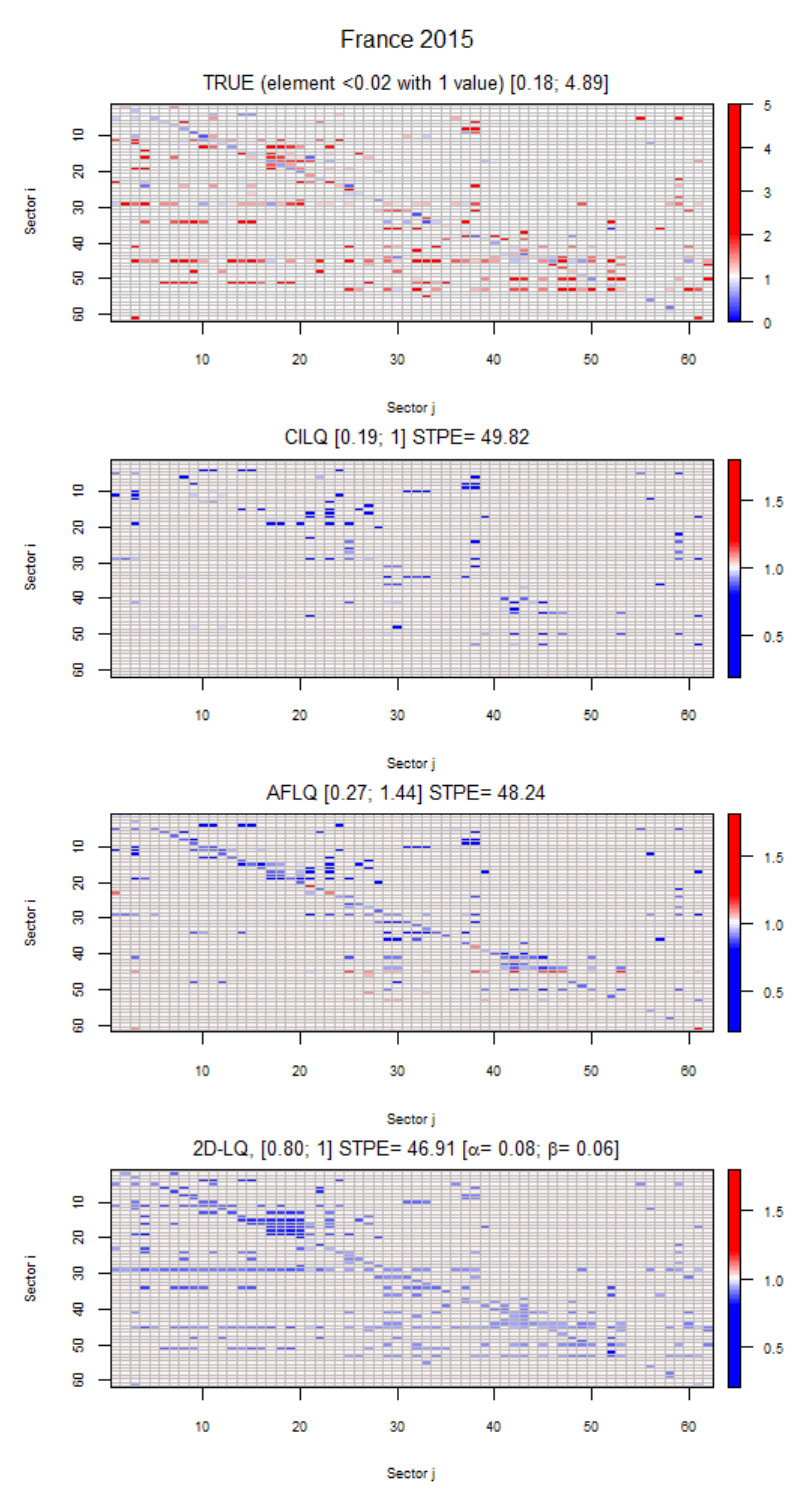
Figure 4. Projections of technical coefficients via LQ versus ideal rectifications (France). Source: internal based on Eurostat data [naio_10_cp1700].